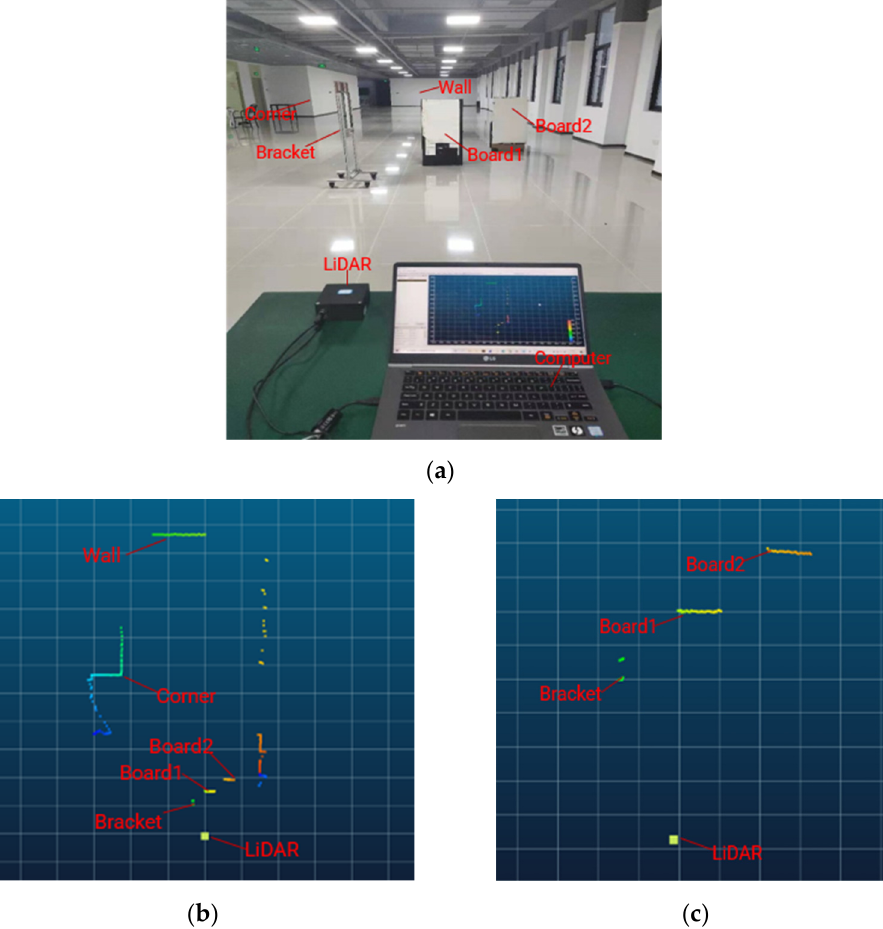
Figure 9. ( a ) The picture of the experiment; ( b ) the panorama of the cloud point; ( c ) the cloud point details.